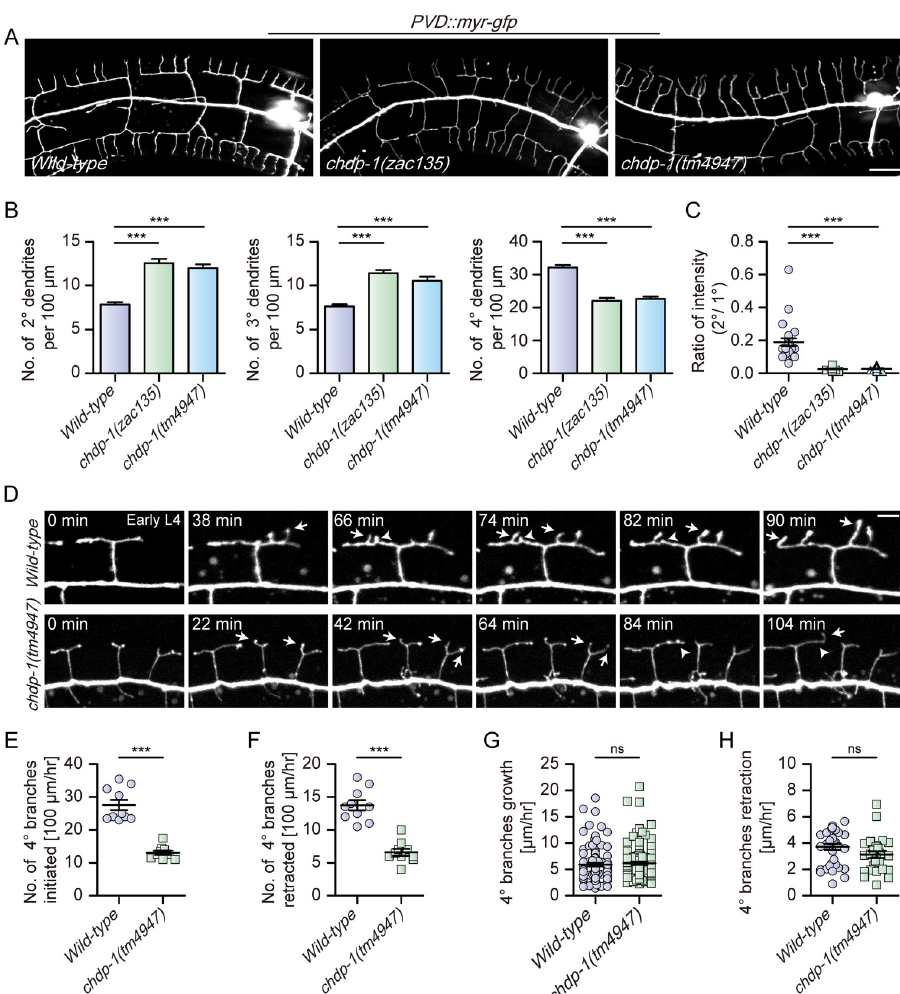
Fig 1. chdp-1 mutants are defective in PVD dendrite morphogenesis. (A) Maximum projection of confocal images showing the PVD morphology of wild-type , chdp-1(zac135) and chdp-1(tm4947) mutant animals at the day 1 adult stage. PVD morphology was visualized using a cell-specific fluorescent marker ( ser2prom3 :: myr-gfp ). Scale bar: 20 μ m. (B-C) Quantification of (B) the number of 2 o , 3 o and 4 o branches, and (C) the ratio of the intensity of the 2 o branches to that of the primary dendrite in wild-type , chdp-1(zac135) and chdp-1(tm4947) in the 100 μ m area anterior to PVD cell body. Error bars: SEM. ��� p < 0.001 by one-way ANOVA with the Tukey correction. n = 20–30 for each genotype. (D) Confocal images from time-lapse movies showing dendrite branching, outgrowth and retraction in wild-type (upper) and chdp-1(tm4947) mutant animals (lower) during early L4 stage. Arrows: 4 o outgrowth, arrowheads: 4 o retraction. Scale bar: 5 μ m. (E-F) Quantification of the number of 4 o branches initiation (E) and retraction (F) per hour in a 100 μ m area anterior to the PVD cell body. Error bars: SEM. ��� p < 0.001 by Student’s t-test. n = 10 animals for each genotype. (G-H) Quantification of the speed of 4 o dendrite growth (G) and retraction (H). Error bars: SEM. ns: non-significant by Student’s t-test. For G, n = 100 branches for each genotype. For H, n = 36 branches for wild-type , and n = 29 branches for chdp-1(tm4947)